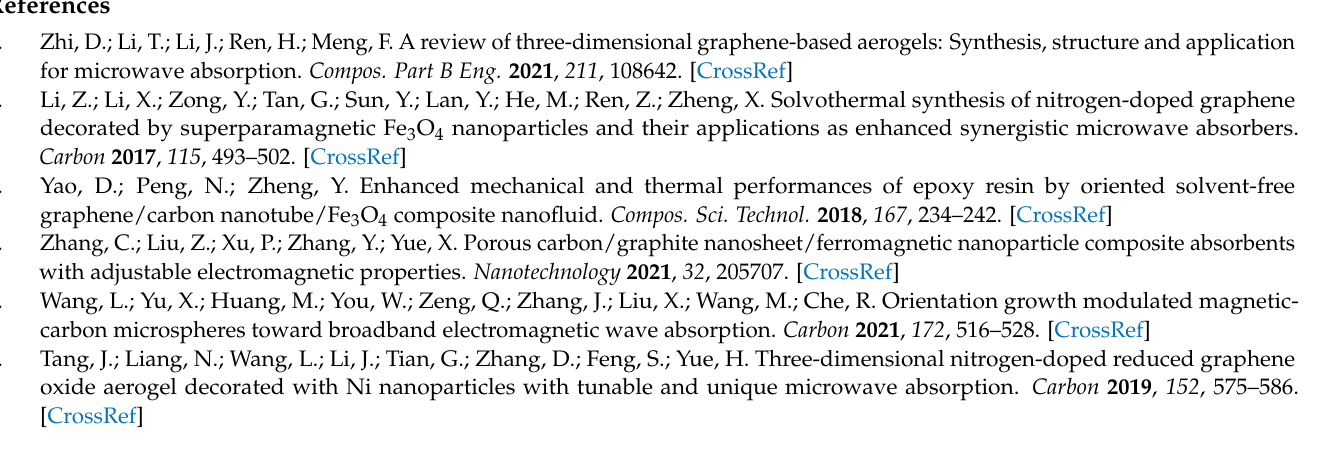
of OCGA-m; Figure S6: SEM images of (a) top region, (b) middle region and (c) bottom region of OCGA-P; Figure S7: (a) Real part of permittivity ( ε (cid:48) ), (b) imaginary part of permittivity ( ε (cid:48)(cid:48) ) and (c) dielectric loss tangent ( tan δ ε ) of OCGA-m, OCGA-P, OCGA-G.; Figure S8: Normalized input impedance ( Z in ) of (a) OCGA-10K, (b) OCGA-15K, (c) OCGA-20K and (d)